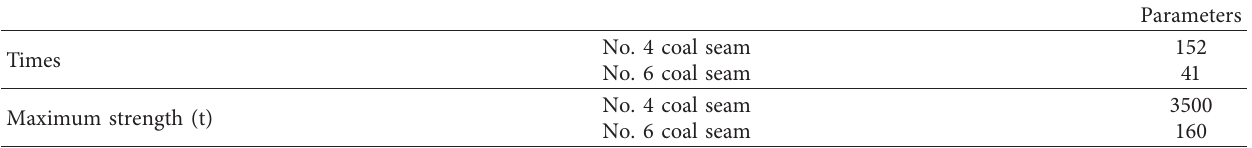
Figure 24: Tectonic outline map of the Nantong Coal Mine Zone.1, Longguxigeo anticline; 2, Conglingou syncline; 3, Xianjiaping anticline; 4, Ganjiaping syncline; 5, Maoyan anticline; 6, Yaqueyan syncline; 7, Bamianshan syncline; 8, Wangjiaba syncline; 9, Wuguishan anticline; 10, Pingtu syncline; 11, Miaoding syncline. Table 2: Compound coal-rock dynamic disasters in Donglin Coal Mine.